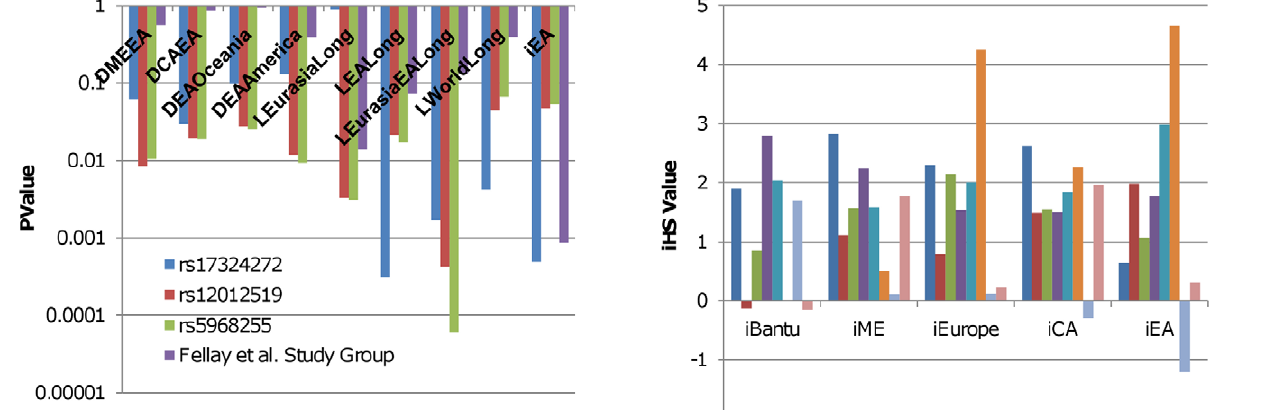
Figure 4. iHS scores for psoriasis SNPs. iHS scores are positive when selection favors the risk allele for psoriasis. The dark blue bars represent rs2201841 at position 67,466,790 on chromosome 1. The red bars represent rs4085613 at position 150,816,642 on chromosome 1. The green bars represent rs20541 at position 132,023,863 on chromosome 5. The purple bars represent rs3213094 at position 158,683,347 on chromosome 5. The teal bars represent rs10484554 at position 31,382,534 on chromosome 6. The orange bars represent rs2395029 at position 31,539,759 on chromosome 6. The light blue bars represent rs610604 at position 138,241,110 on chromosome 6. The pink bars represent rs2066808 at position 55,024,240 on chromosome 12. It should be noted that both rs10484554 and rs2395029 are in the HLA region and are less than 1MB apart.